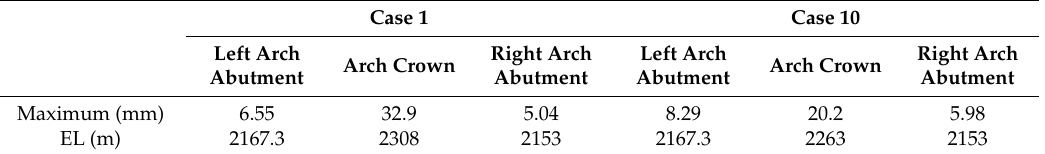
Table 5. Maximum displacement along river direction at different key locations under analysis cases 1 & 10.